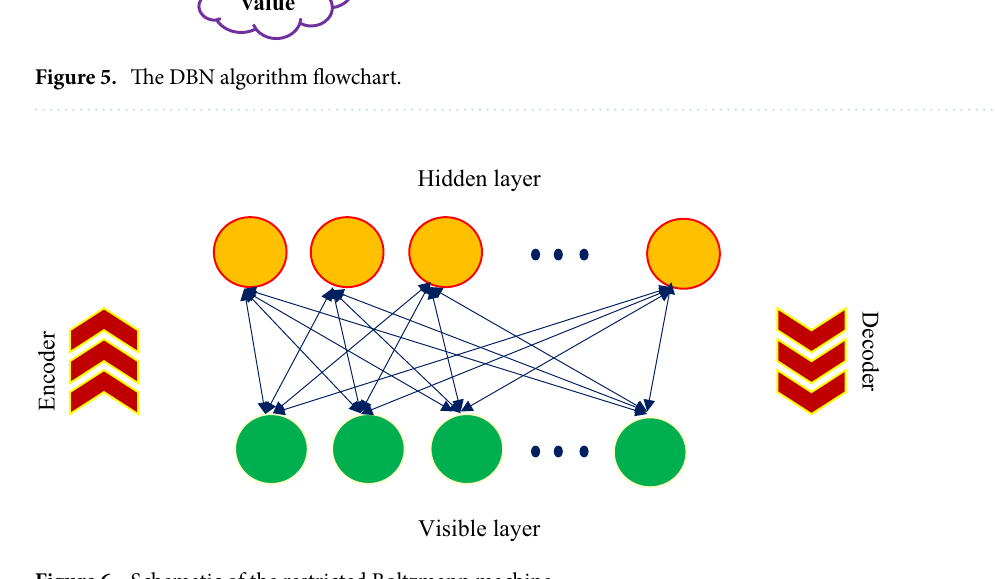
Figure 6. Schematic of the restricted Boltzmann